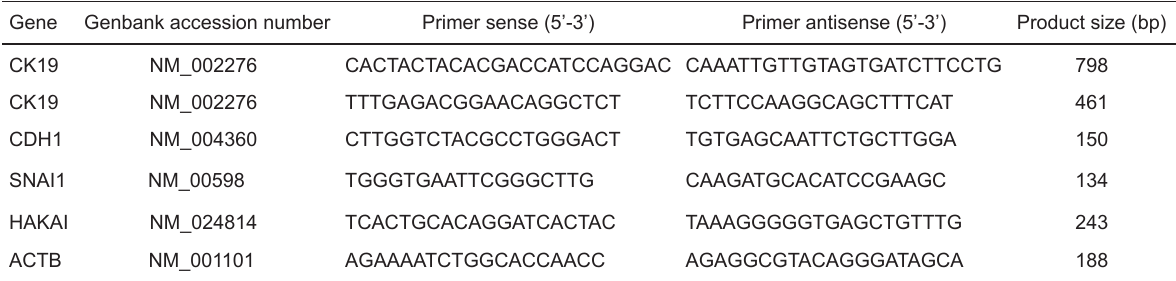
Table 3. Primer sequences used in